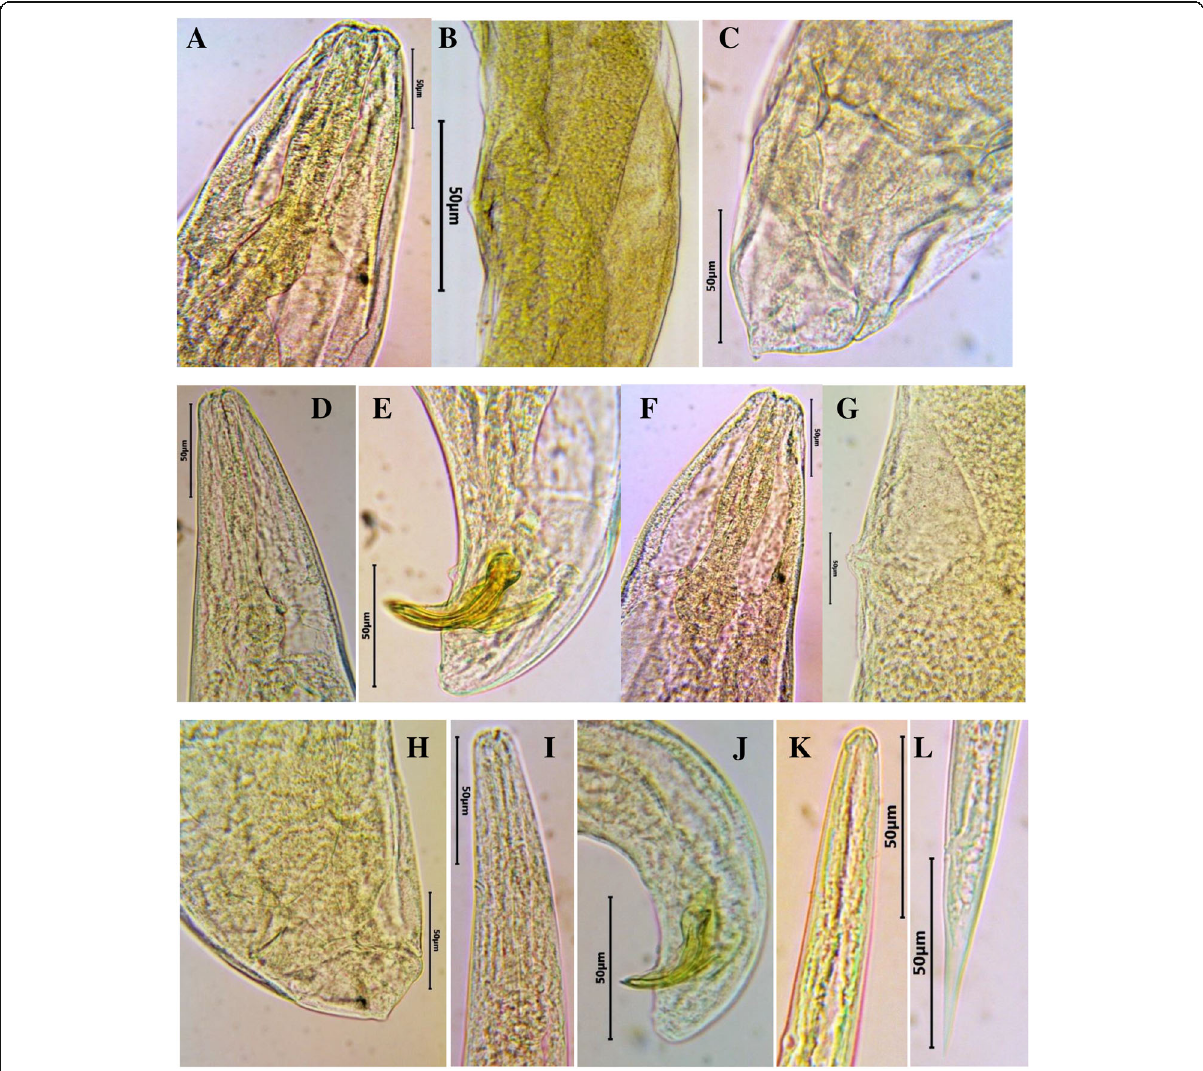
Fig. 1 Light microscope image of Steinernema abbasi CS38 drawn to scale at 400X. a – c : 1 st generation female, a- anterior region, b- vulva region, c- posterior region. d – e : 1 st generation male, d- anterior region, e- posterior region. f – h: 2 nd generation female, f- anterior region, g- vulva region, h- posterior region. i – j: 2 nd -generation male, i- anterior region, j- posterior region. k – l : Infective juveniles, k- anterior region, l- posterior